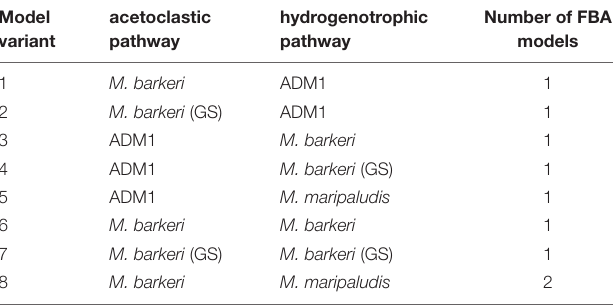
TABLE 3 | Model coupling variants.